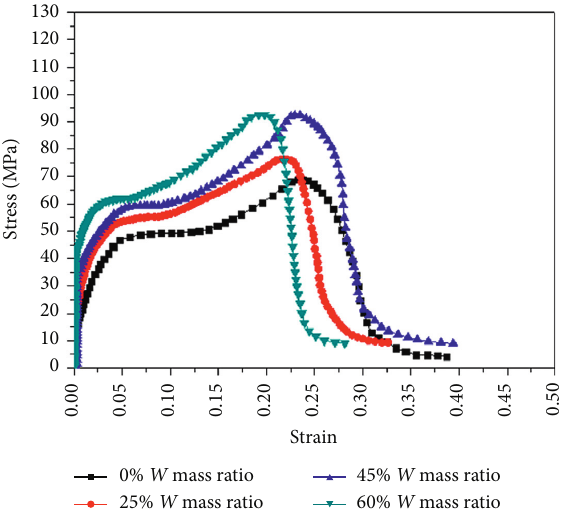
Figure 4: Stress-strain curves of Al/PTFE/W energetic materials with different W contents (the strain rate was 4500s − 1 ).